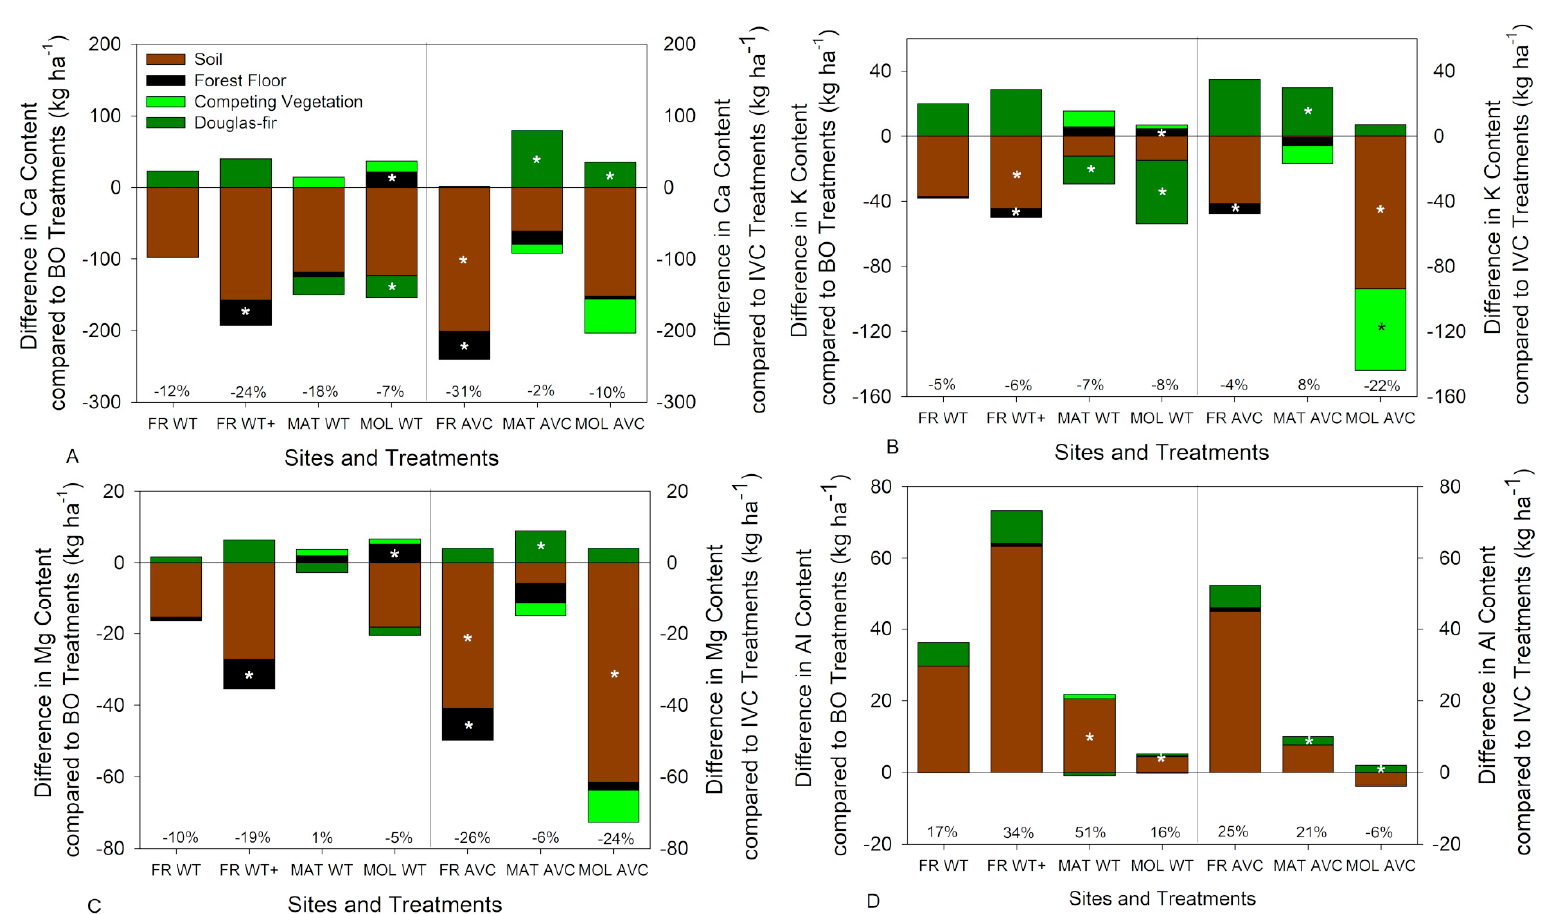
Figure 7. Net Ca ( A ), K ( B ), Mg ( C ), and Al ( D ) nutrient pools in whole tree removal treatments (left frame: WT or WT+ minus BO treatment) and annual vegetation control (right frame: AVC minus IVC treatment) at Fall River (FR), Matlock (MAT), and Molalla (MOL). Asterisks denote significant differences from the BO or IVC treatments. Values at the bottom of each graph are the total percent difference from the BO or IVC treatment.